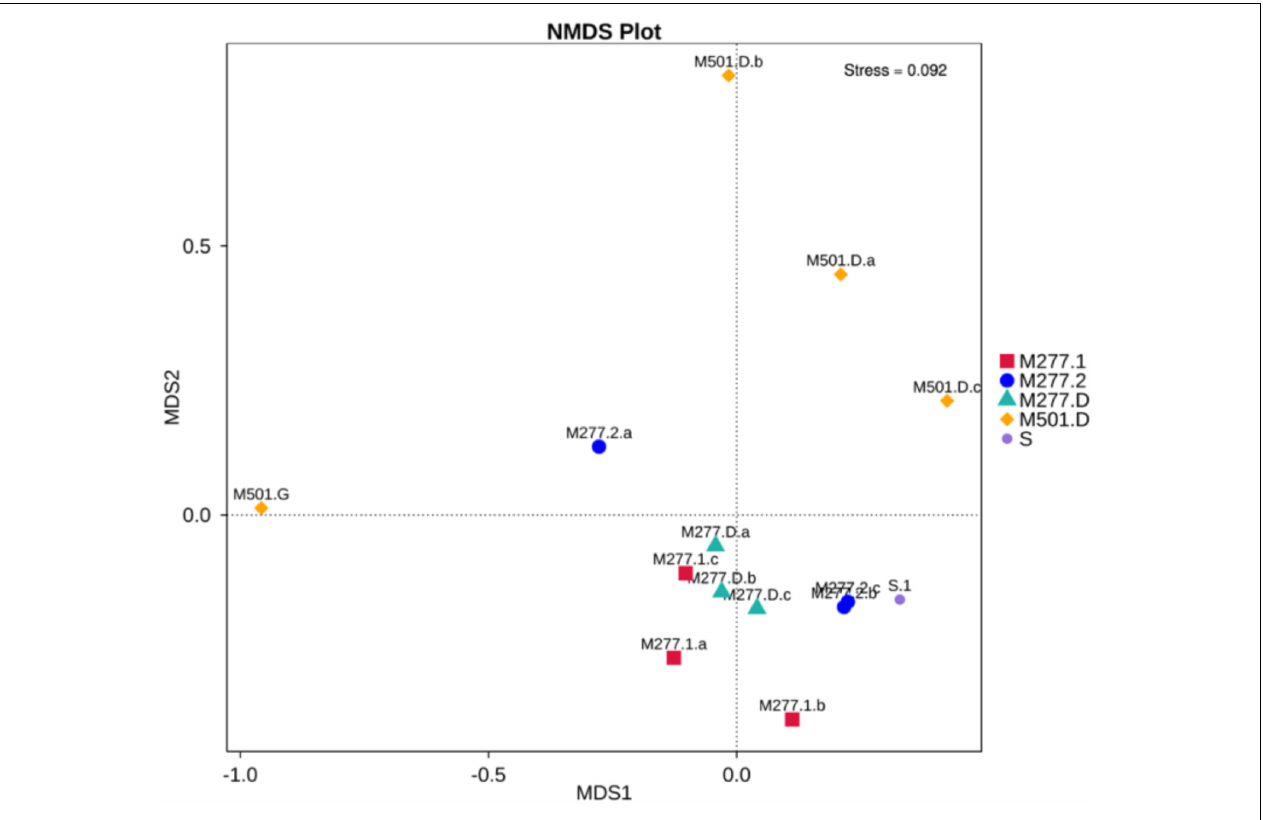
FIGURE 9 | NMDS of microbial community structure and composition of